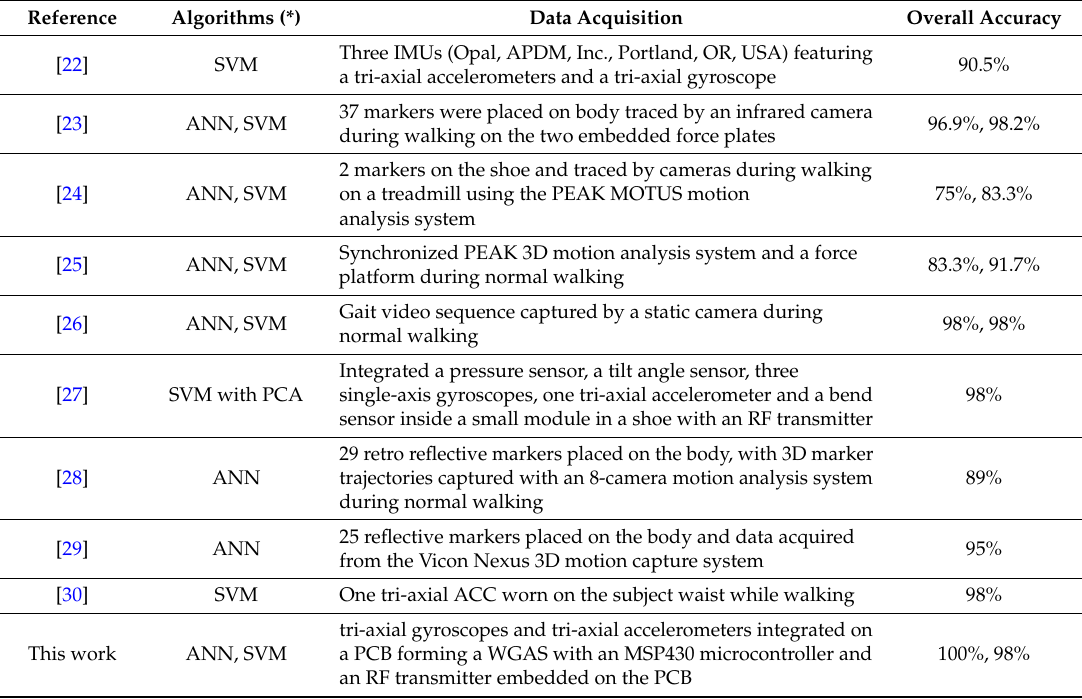
Table 9. Our real - time WGAS gait classification system vs. the